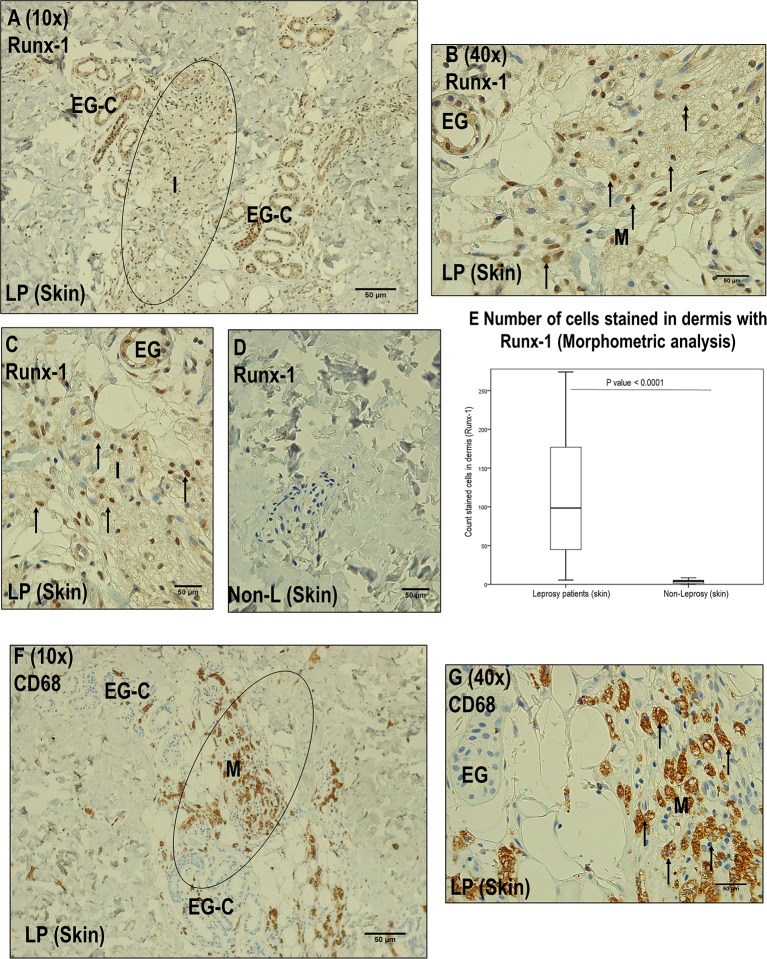
Immunohistochemistry with Runx-1 in leprosy skin vs. non-leprosy skin. (A) Image (10x magnification) showing leprosy dermis (LP), with inflammatory cells stained with Runx-1 (I) surrounding eccrine glands. (B) Image (40X magnification) showing a zone marked in (A) showing positive Runx-1 stained cells (macrophages, M). (C) Dermic inflammatory infiltrated sample (I) stained with Runx-1. (D) Non-leprosy dermic sample (Non-LP) negative for Runx-1. (E) Comparison of the Runx-1 stained cells in leprosy vs. non-leprosy skin samples (P < 0.05). (F) Image (10x magnification) showing a leprosy skin sample (LP) stained with CD68 to confirm the presence of macrophages (M) in the inflammatory infiltrate (I) surrounding eccrine glands. (G) Image (40X magnification) showing the zone marked in (F) showing macrophages (M). All the figures have a 50-μm scale bar.